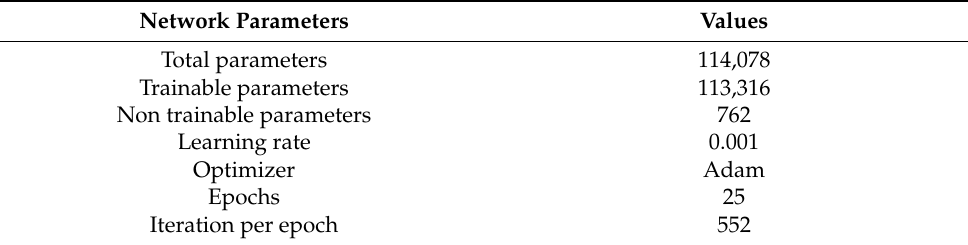
Table 2. Details concerning the network